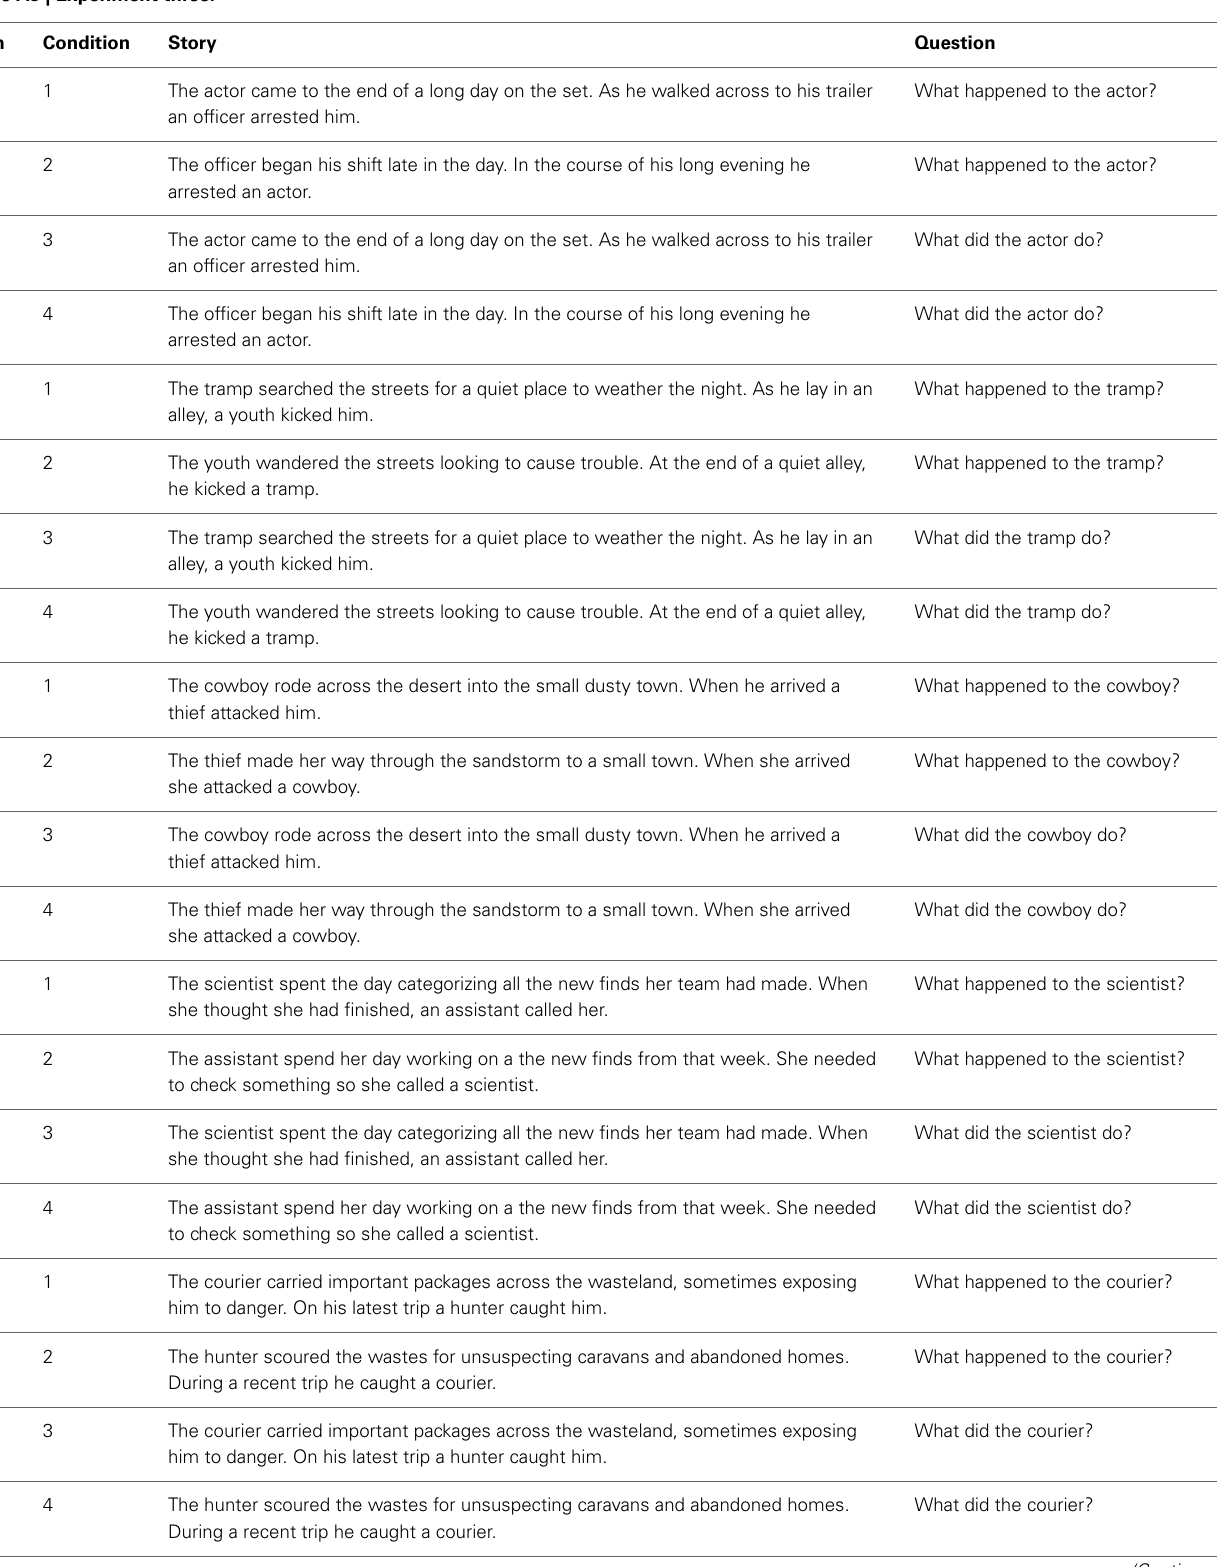
Table A3 | Experiment three. Item